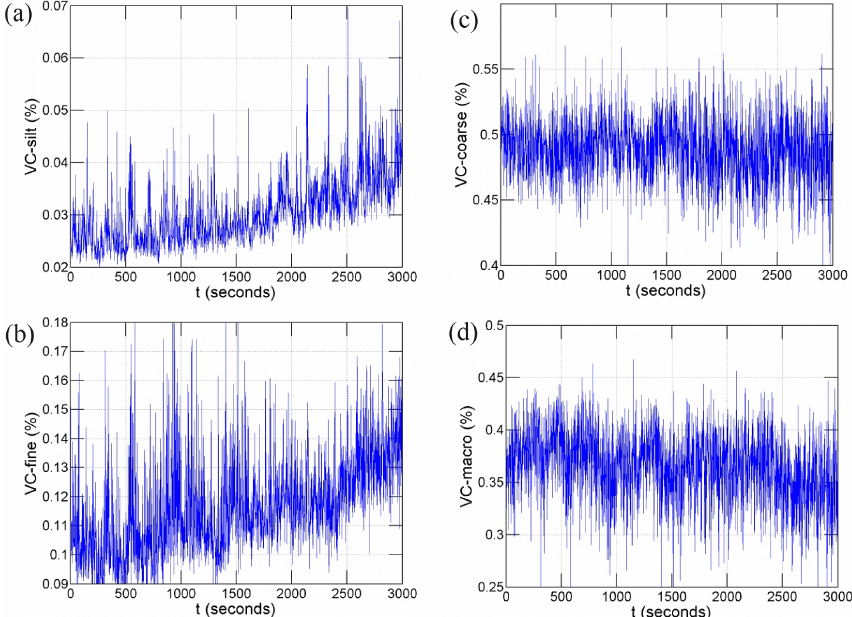
Figure 2. The first 3000 samples of the time series of volume concentrations of different size classes of PSD. (a) Silt/clay, (b) fine particles, (c) coarse/micro particles and (d) macro